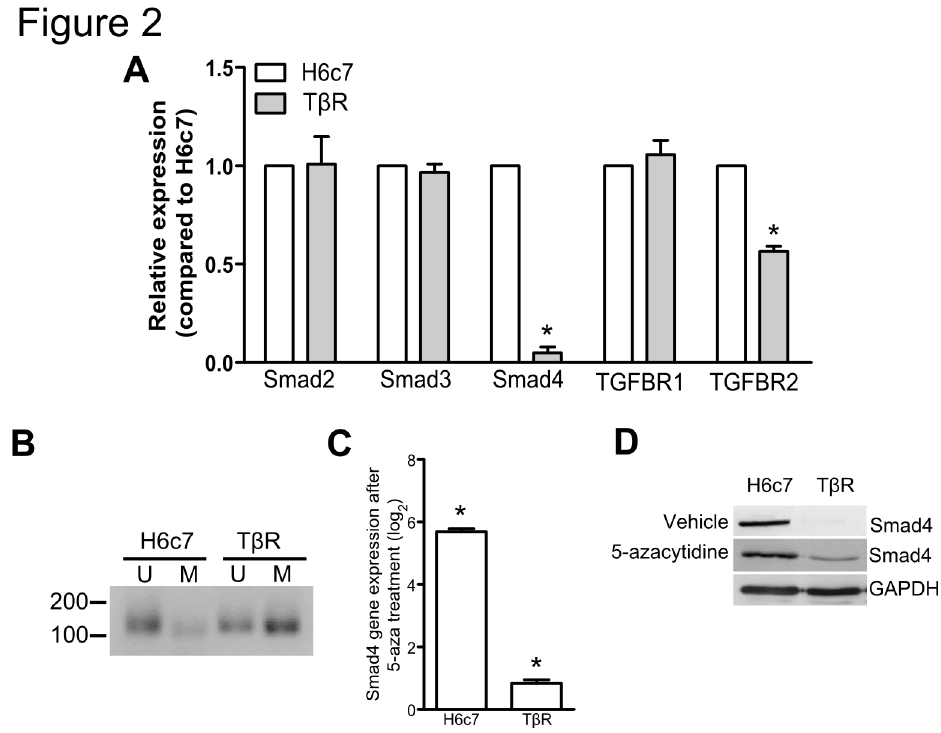
Figure 2. Characterization of the TβR cell line . ( A ) Smad and TGF-β receptors expression were assessed by qPCR and compared to the control H6c7 cell line. ( B ) Methylation specific PCR was performed on bisulfite treated gDNA isolated from H6c7 and TβR cells. Where U and M represent unmethylated and methylated, respectively. H6c7 and TβR cells were treated with 5- azacytidine and Smad4 expression was assessed by ( C ) qPCR and ( D ) immunoblotting. (* denotes significant differences between H6c7 and TβR cell lines or treated compared to vehicle where appropriate, student t-tests, p<0.05, n=3; data are presented as mean ± SEM)